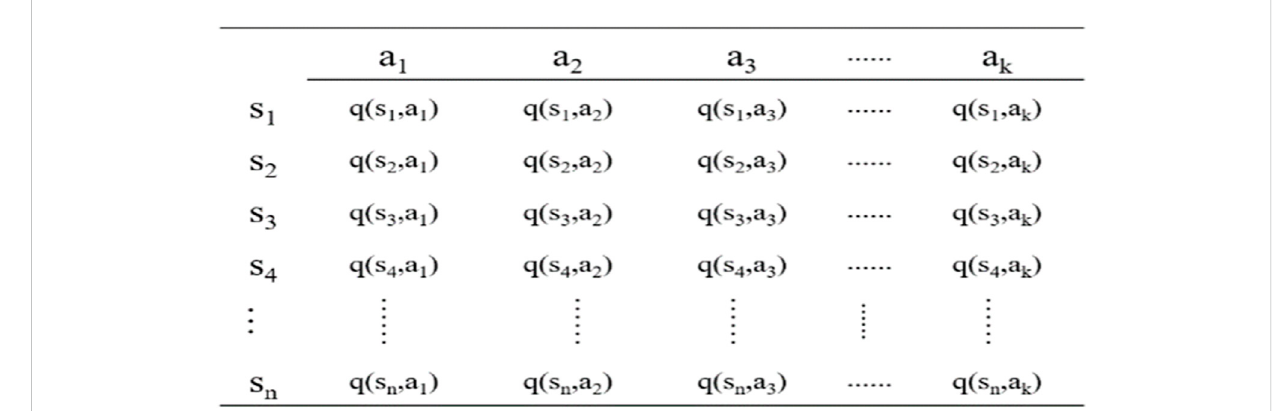
FIGURE 1 The Q table for knowledge describing.